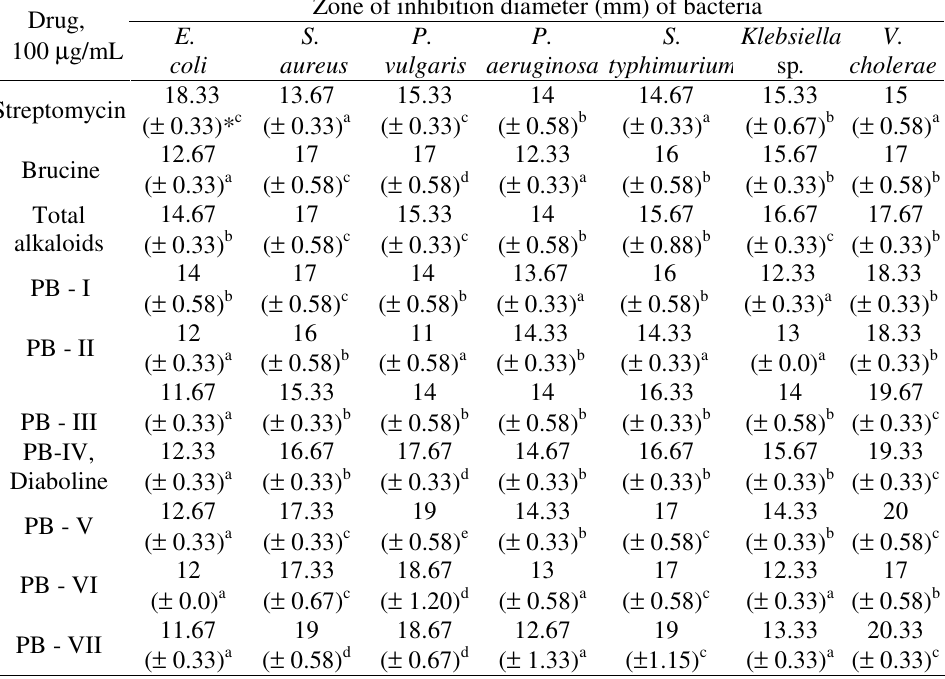
Table 1. Antibacterial activity of Strychnos potatorum alkaloid